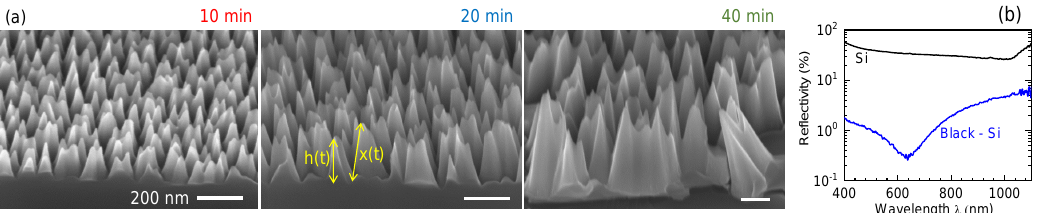
Figure A1. Topography and reflectivity of as-fabricated b-Si. ( a ) SEM micrographs at 45 ◦ tilt of b-Si etched for 10, 20 and 40 min, respectively. The height h ( t ) and side-length x ( t ) of nano-pyramids evolution during etch time t was used to evaluate surface area, see text for details. ( b ) Reflectivity of b-Si etched for 15 min was R < 1% over most of visible spectral range. Reflectivity of Si (100) wafer is shown for reference. Until the bandgap energy 1.12 eV ( λ = 1107 nm), reflectivity R = ( n dominated by the high real part of the refractive index, n ; for normal incidence in air n a =